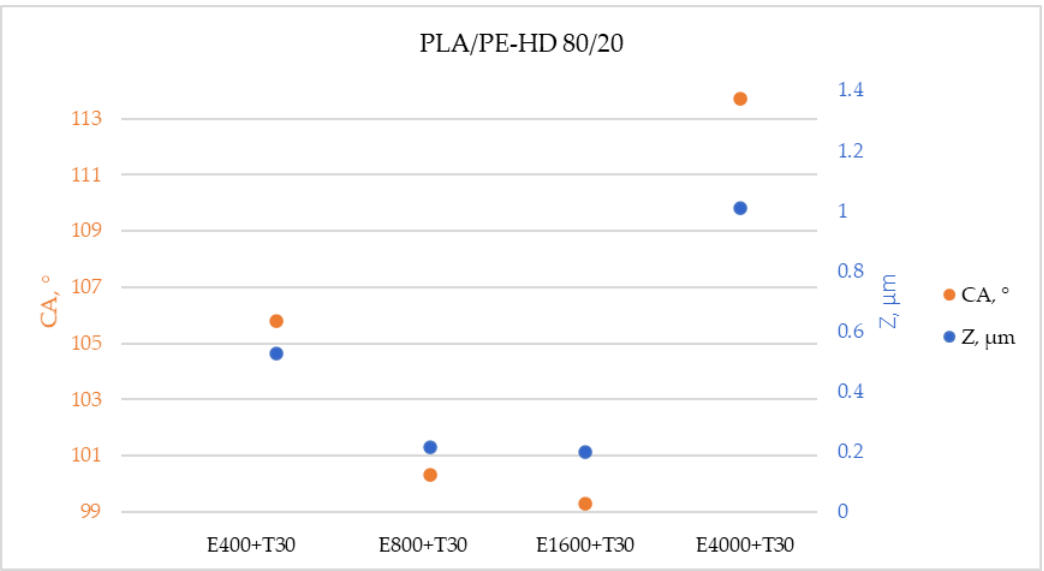
Figure 8. Results of the vertical scanning interferometry (VSI) - trend of contact angle and island height change in relation to applied treatment on PLA/PE-HD 80/20 (E—etching in s, T—CF x coating in min, CA—contact angle, Z—island height).